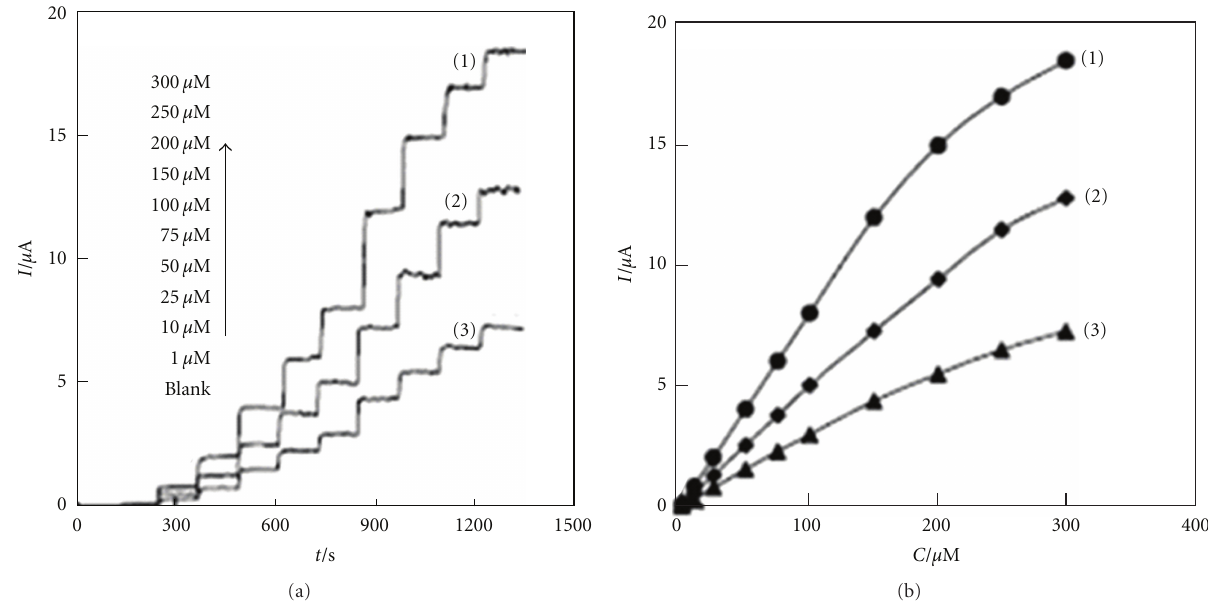
Figure 8: (a) Current-time recording and (b) calibration curve of the tyrosinase-modified BDD electrode to p -cresol (1), 4-chlorophenol (2), and phenol (3). Supporting electrolyte was 0.1M PBS (pH 6.5). Applied potential was − 0.15 V versus SCE.